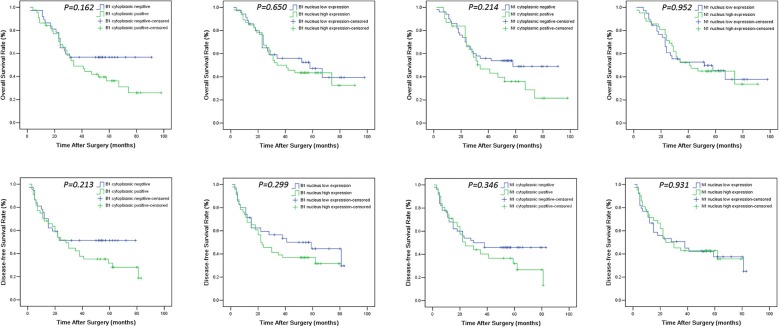
Overall survival (OS) and disease-free survival (DFS) Kaplan-Meier curves of HNSCC patients according to expression levels of HMGB1 and HMGN1 in nucleus and cytoplasm. For determination of the p-values the log-rank test was used.